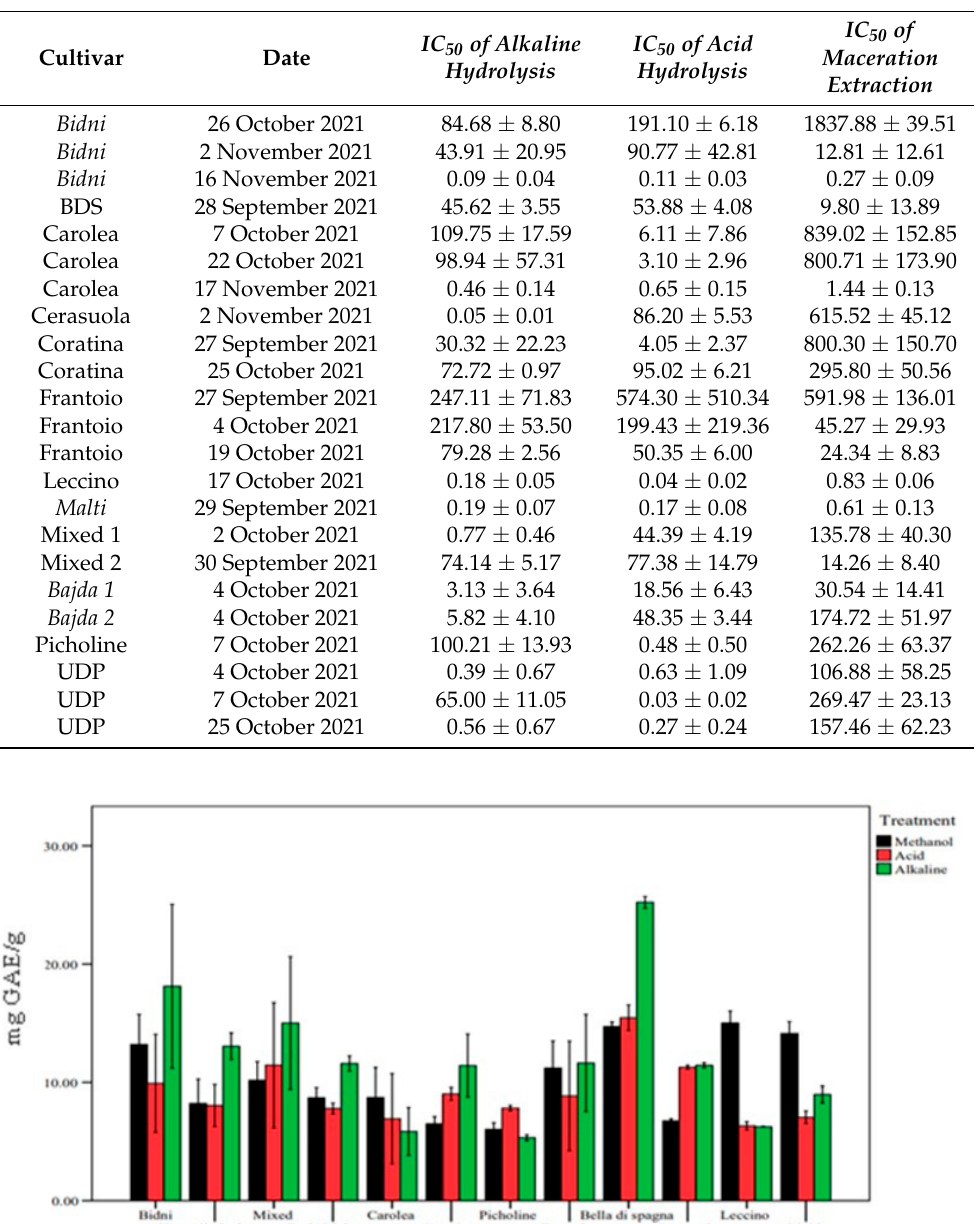
Figure 7. Mean of ferric reducing antioxidant activity of olive mill waste extracts using three differ- ent solvent extraction methods—methanol, acid and alkaline (black, red and green bars, respec- tively) with error bars showing ± 1SD for three independent trails.